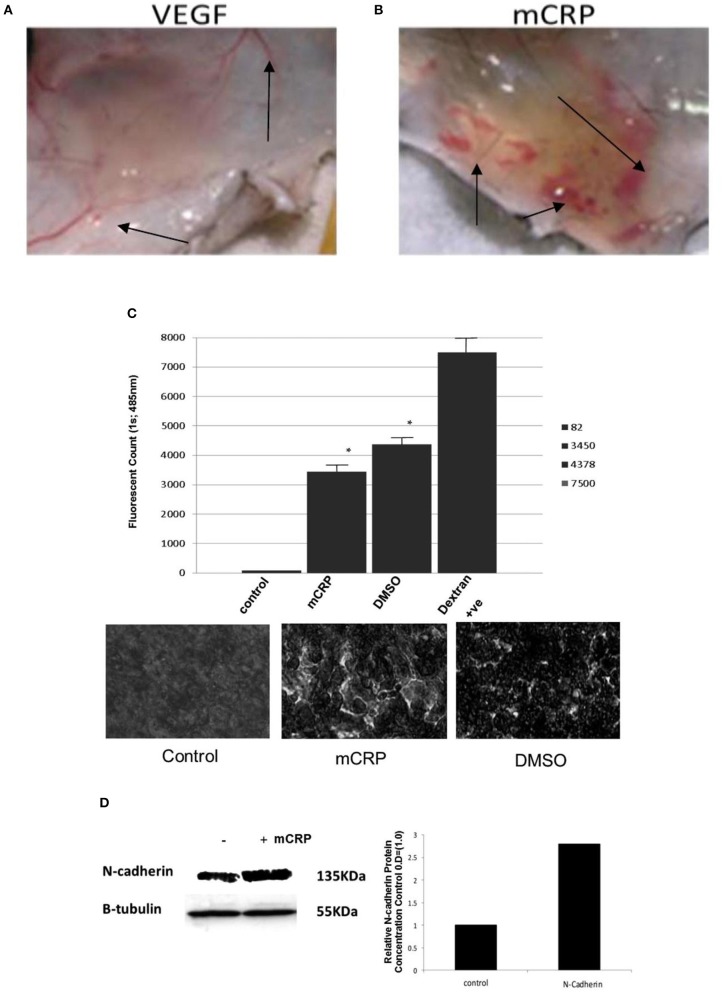
mCRP increases vascular permeability and aberrant angiogenesis. Top shows hemorrhagic blood vessels produced within a matrigel murine skin implant-compared with normal vessels after VEGF incorporation. Dorsal matrigel implants containing mCRP (10 μg/ml; 72 h) produced strong and visible hemorrhagic angiogenesis (B; arrows) compared with a typical, normal looking vascular response seen in the presence of VEGF (A; 25 ng/ml). In (C) the graph shows a significant increase in monolayer permeability in the presence of mCRP (10 μg/ml; 8 h) using a Millipore-based filter assay, similar to that produced by 10% DMSO (p < 0.01 increase in FITC dextran penetrating the monolayer in the presence of either mCRP or the positive control DMSO), and lighter regions in the images shown indicate areas of increased permeability. Lower images show intact control monolayer (left); mCRP-treated monolayer and (right) DMSO-treated monolayer showing enhanced permeability and surface damage. Lighter regions in the images shown indicate areas of increased permeability. (D) Expression of adhesion molecules was examined in BAEC treated with mCRP (10 μg/ml; 24 h). NCAM expression was increased by approximately 2.8-fold whilst VCAM, ICAM and integrins were not affected (data not shown). β-tubulin was used as the house keeping control (gel and bar chart shown). Reproduced with permission from (34).